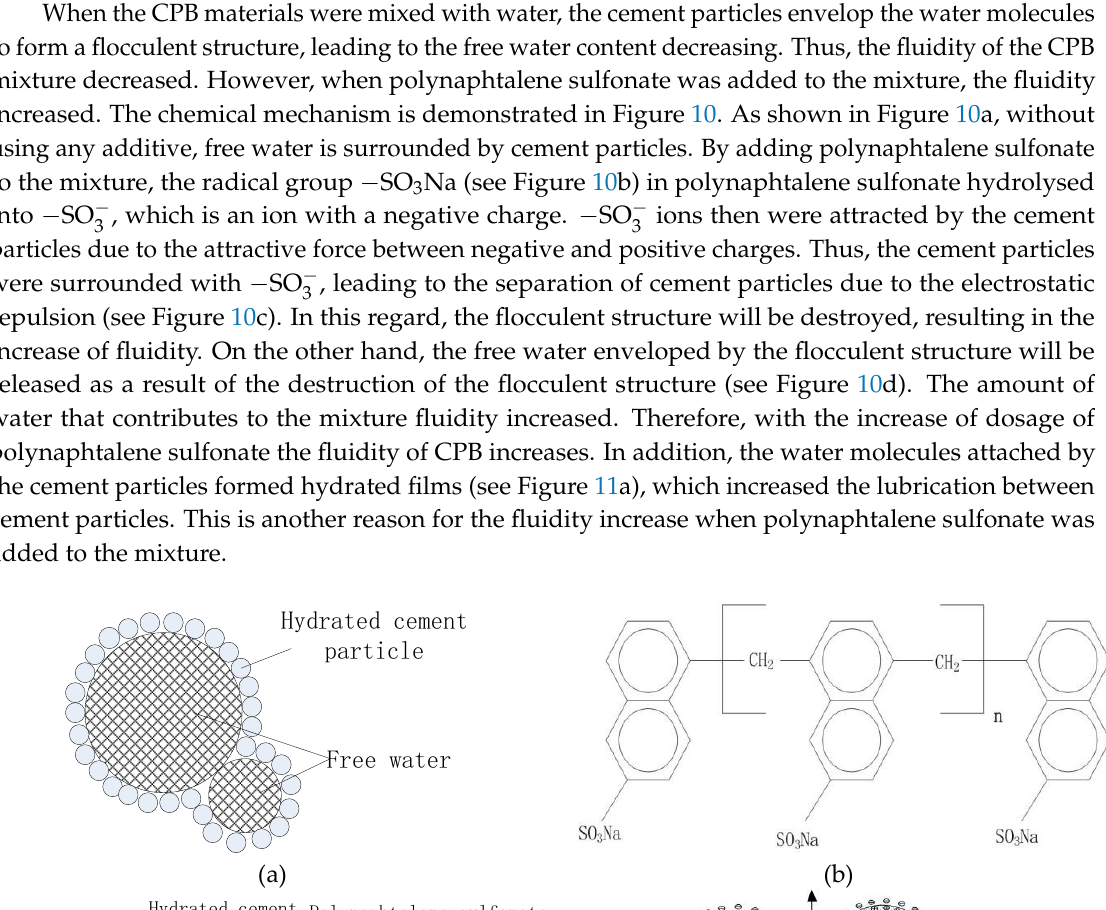
Figure 9. The long-duration T 2 relaxation time of CPB mixture with different polynaphtalene sulfonate dosages when the hydration time is: ( a ) 1 d, ( b ) 7 d, ( c ) 14 d, and ( d ) 28 d.